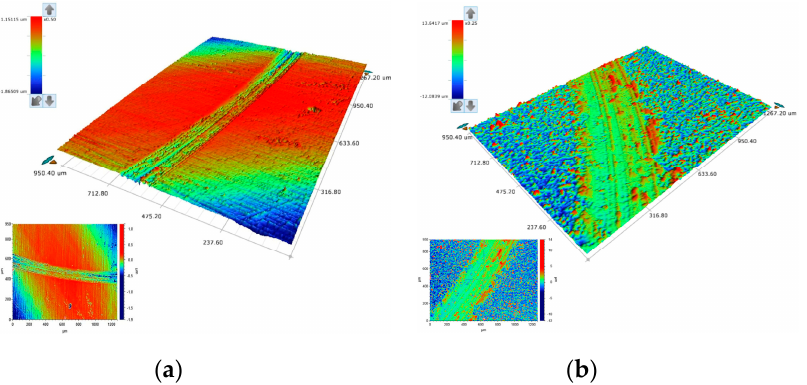
Figure 14. 3D and corresponding 2D plots of the wear tracks of ( a ) pure SnNi (Sample I) and ( b ) composite Sn–Ni/N,S TiO 2 (Sample B).